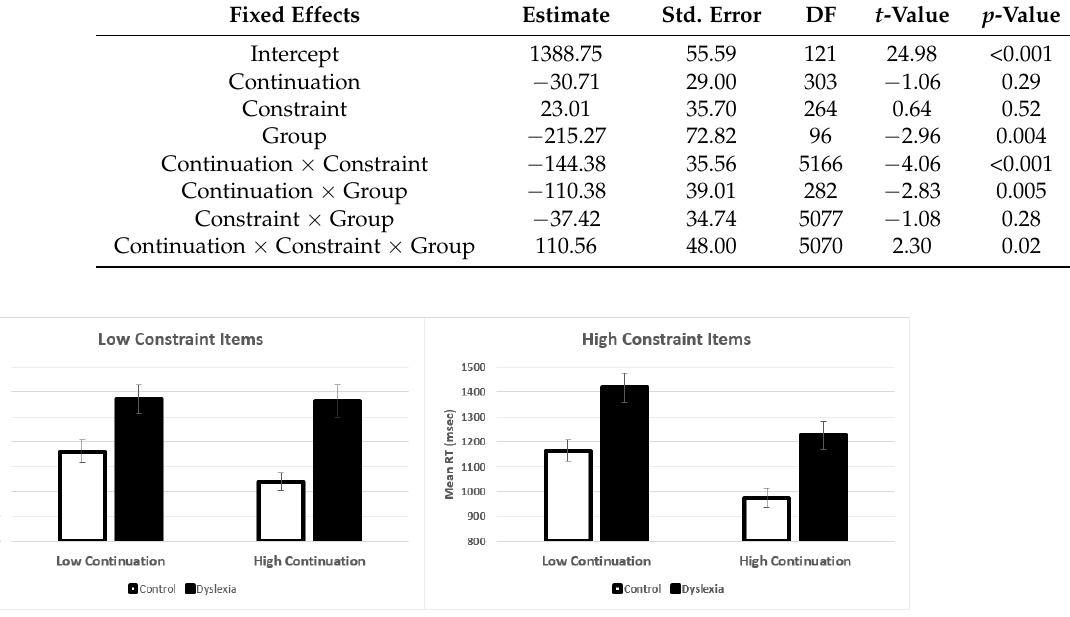
Table 4. Results of paired comparisons.